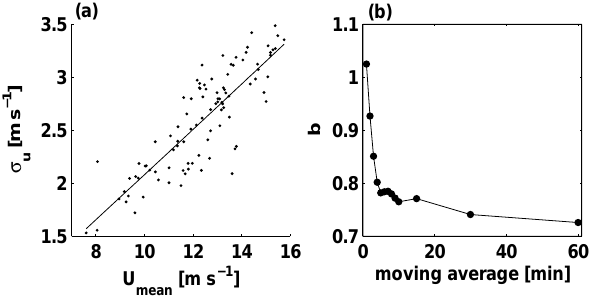
Fig. 6. (a) The scatter plot of σ u , obtained by subtracting the 1min moving average from the entire bora episode, vs. U . The solid line represents the Eq. (4a) fit. (b) The power coefficients b from (a), for different moving averages subtracted from the entire bora